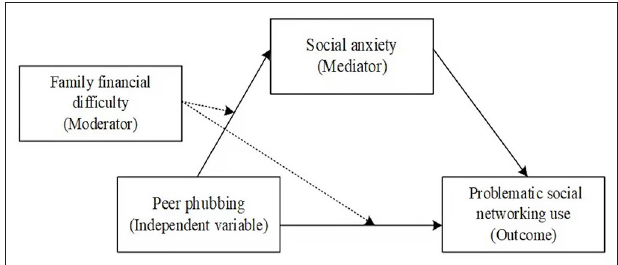
FIGURE 1 | The proposed moderated mediation